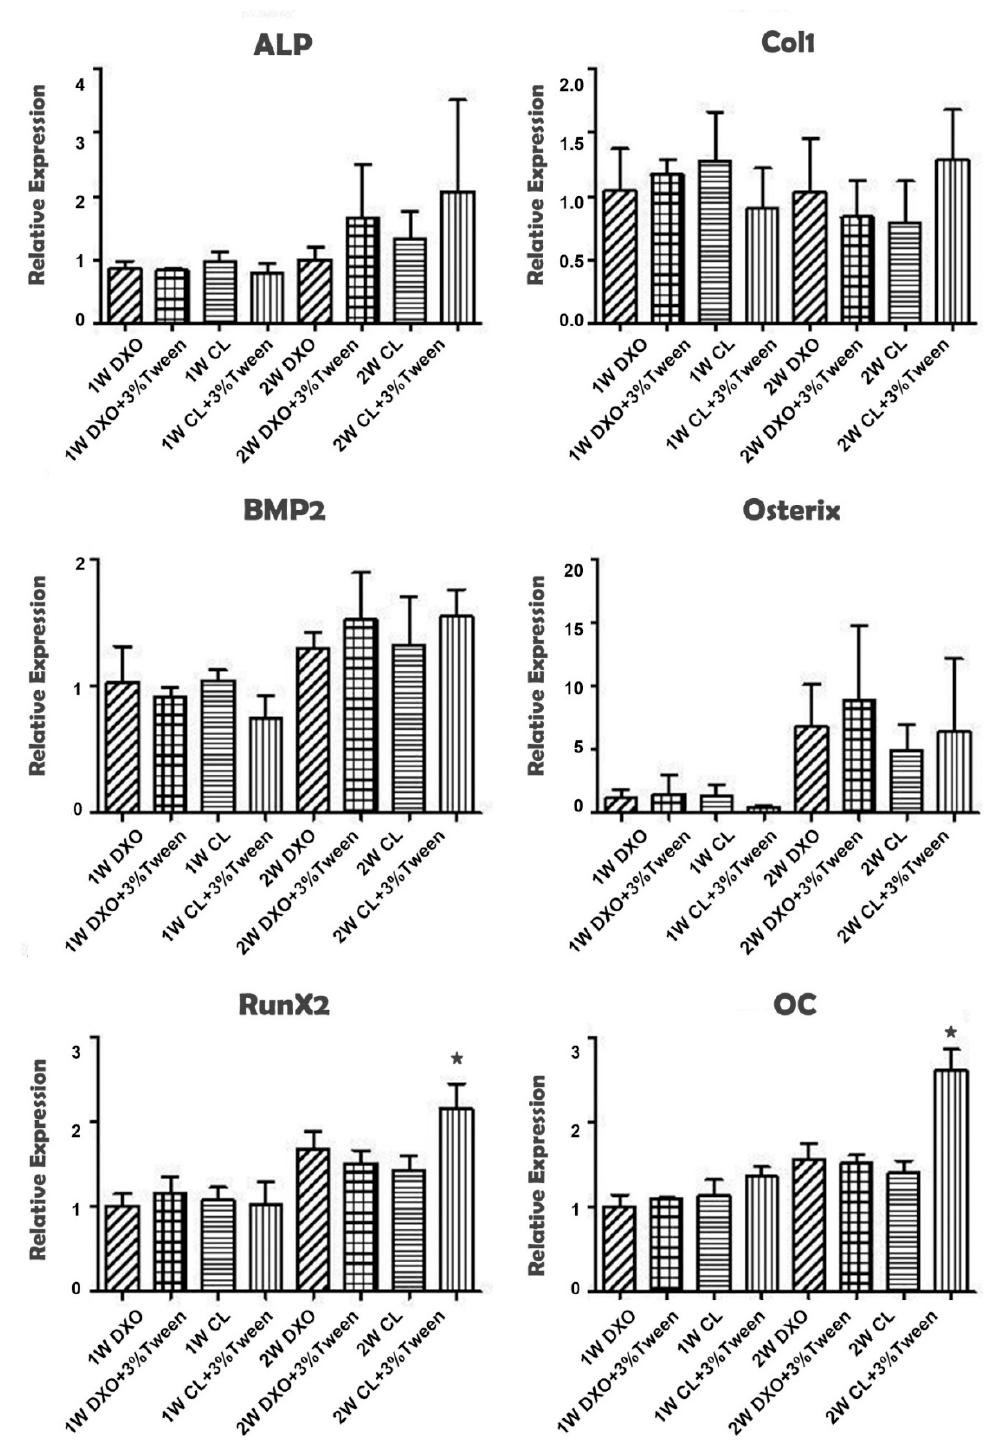
Figure 6. Quantitative real-time reverse transcriptase (RT)-PCR analysis from DXO, CL, DXO plus 3% Tween, and CL plus 3% Tween groups after culturing for 1 and 2 weeks. Runt related gene 2 (Runx2) and osteocalcin (OC) showed significant higher expression from the CL plus 3% Tween group after 2 weeks’ culture (* p <